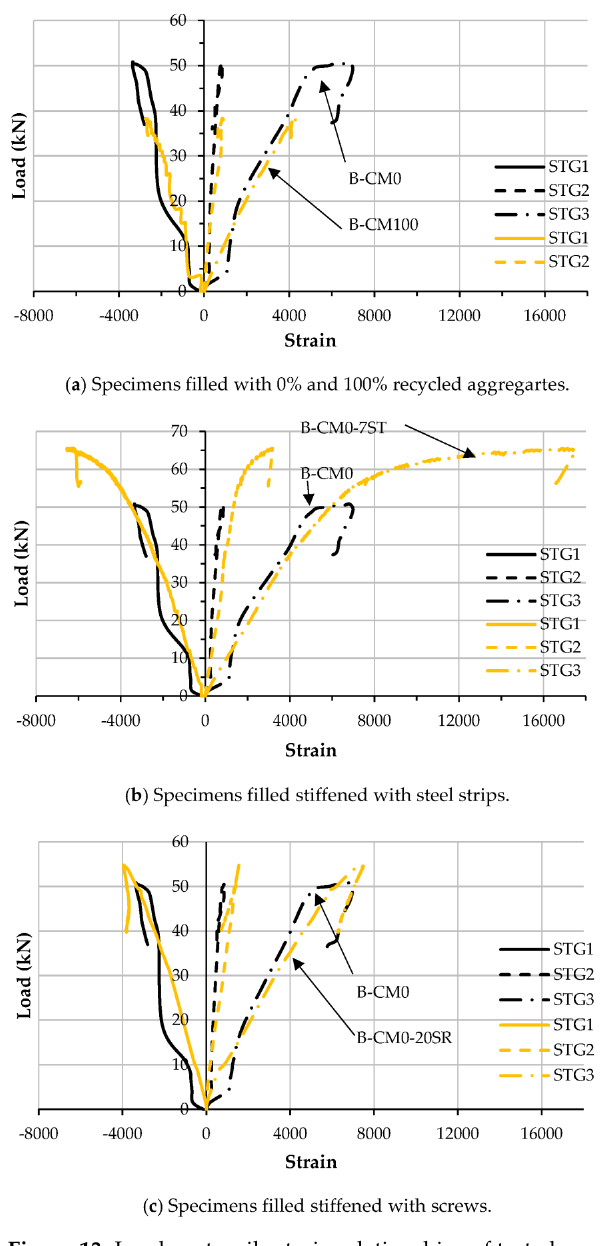
Figure 13. Load vs. tensile strain relationships of tested specimens.